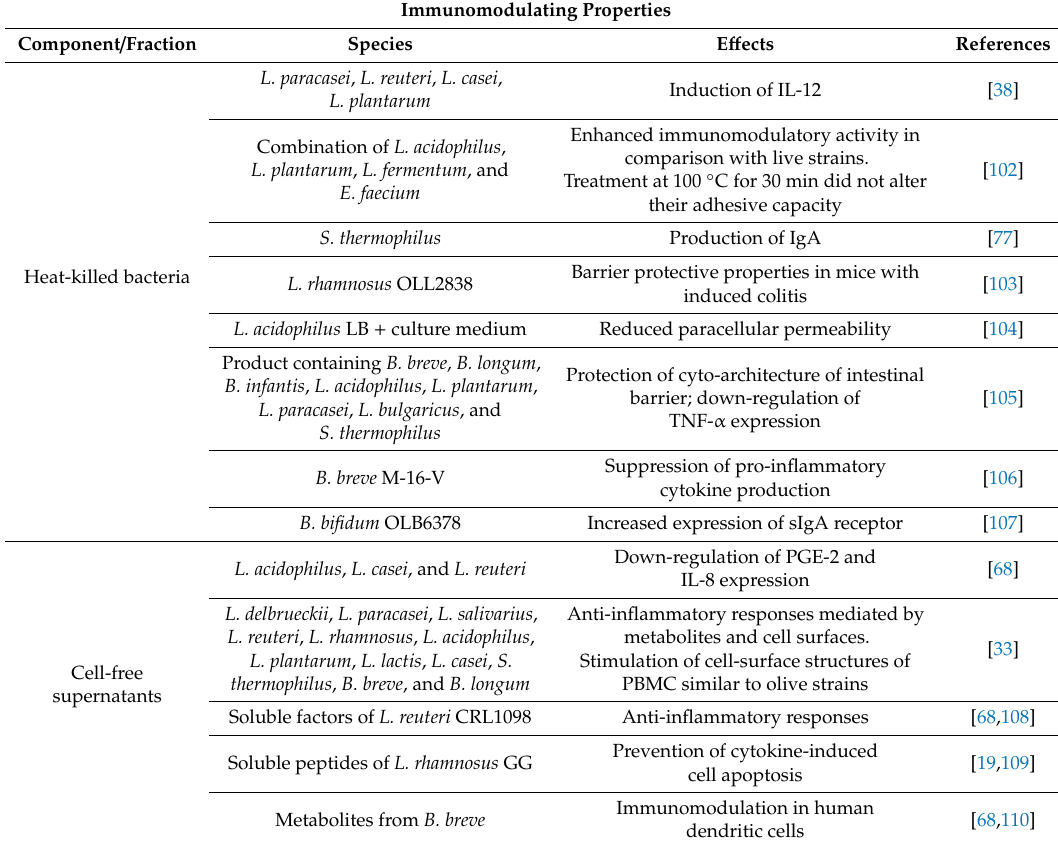
Table 2. Immunomodulating e ff ects of heat-killed bacteria and cell-free supernatants. Immunomodulating